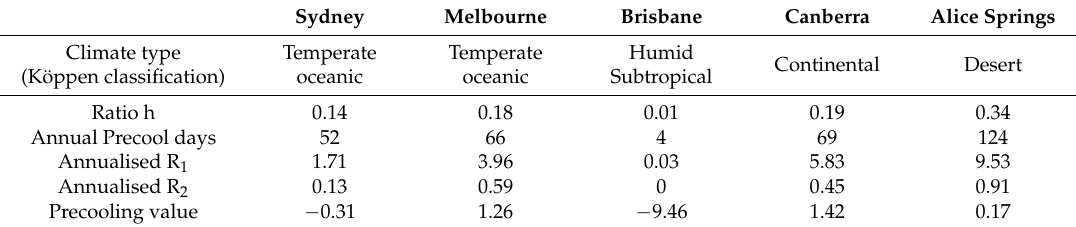
Table 9. Comparison of precooling potential in different